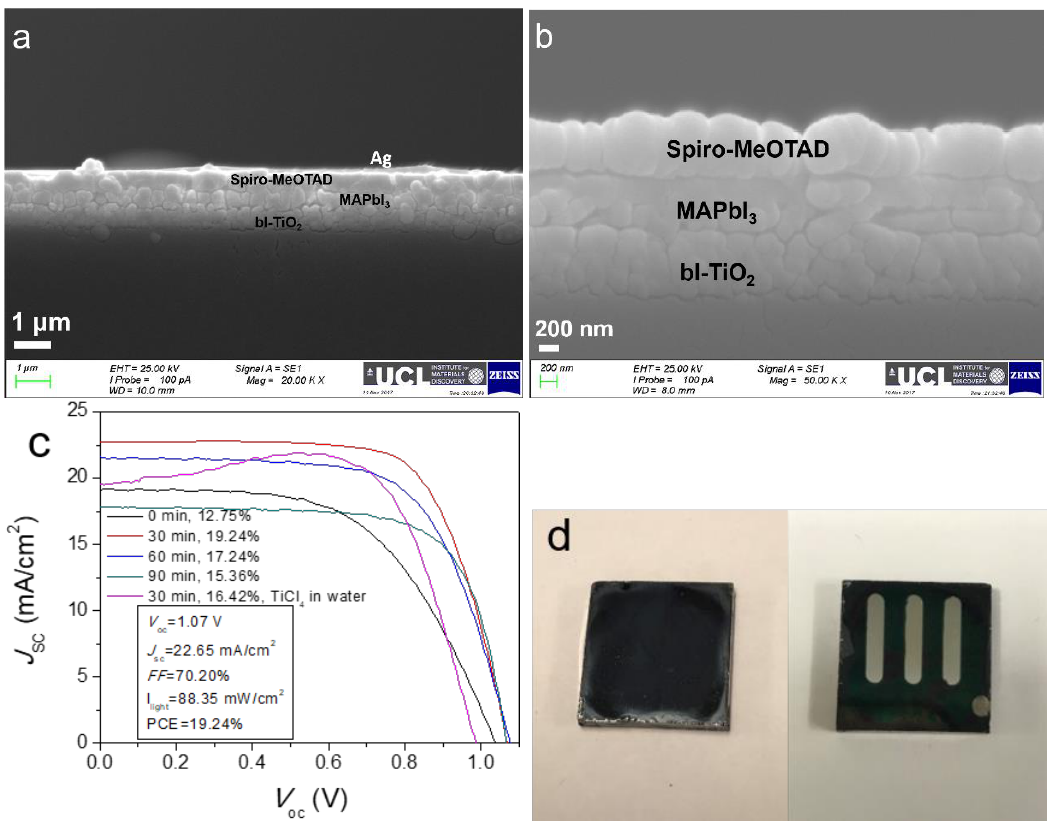
Figure 6. Cross-sectional SEM images at low and high magnifications ( a , b ) and typical J-V curves ( c ) of perovskite solar cells with a typical configuration of FTO/TiO 2 /MAPbI 3 /Spiro-MeOTAD/Ag and ( d ) digital pictures of thermally annealed perovskite film on TiO 2 /FTO glass and one PSC device.